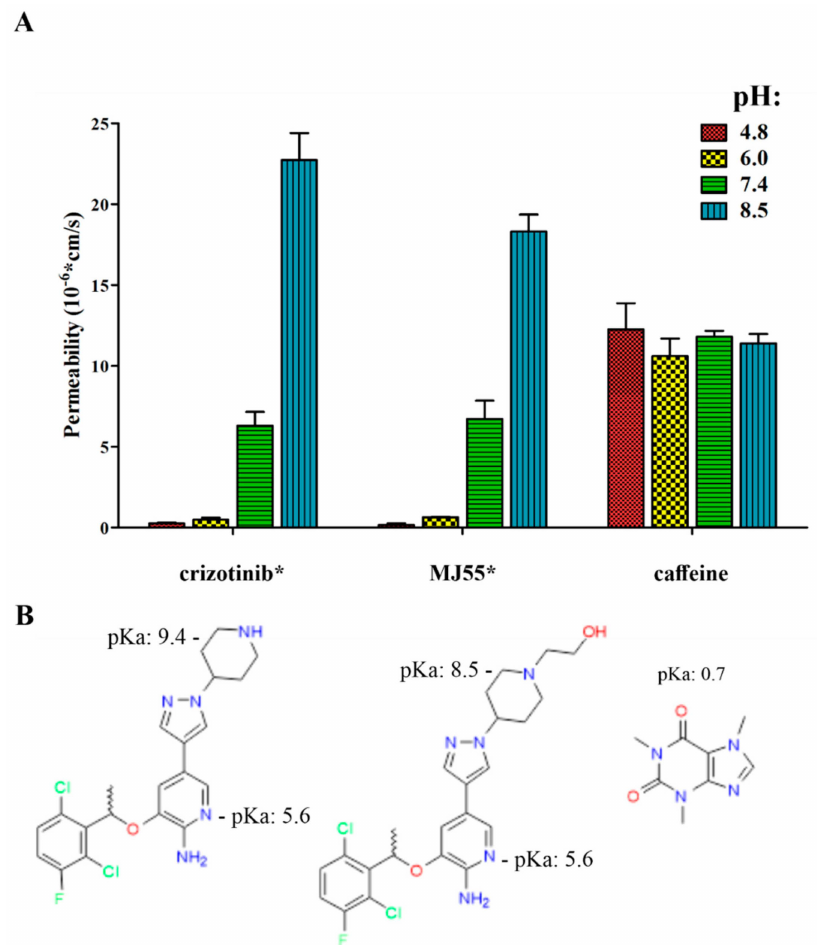
Figure 7. The pH-dependent artificial membrane permeability assay revealed the lysosomotropic character of crizotinib* and MJ55*. ( A ) Permeability of crizotinib* and MJ55*. Ca ff eine was used as control; ( B ) the pKa value of the pyridinium cation is ~5.6 in crizotinib [20] and MJ55*. The pKa value of the piperidinium cation is 9.4 in crizotinib* [20] and 8.5 in MJ55* (predicted by ChemDraw Prime